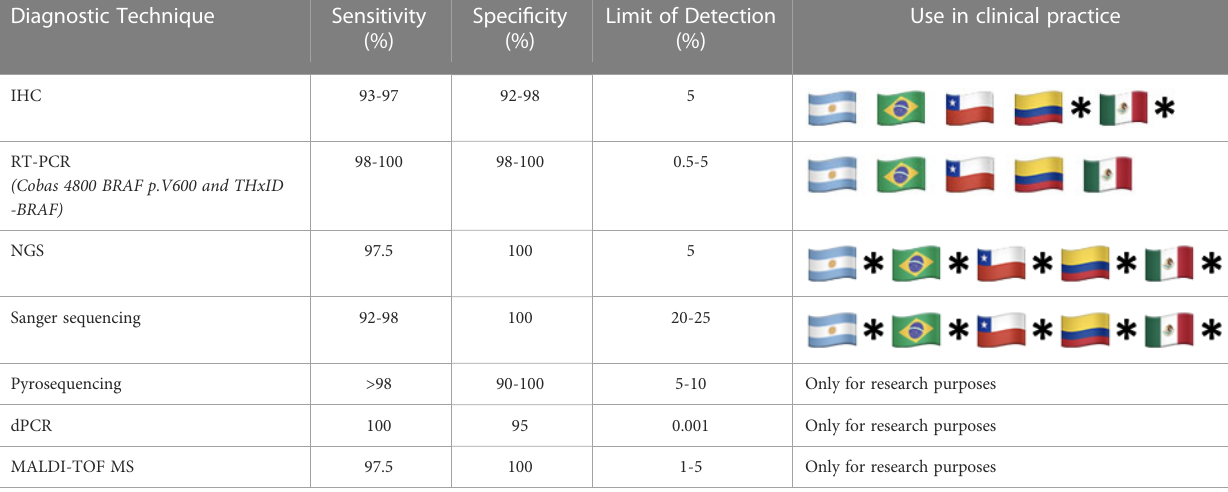
TABLE 1 Sensitivity, speci fi city, and use in LA clinical practice for common BRAF diagnostic techniques. Diagnostic